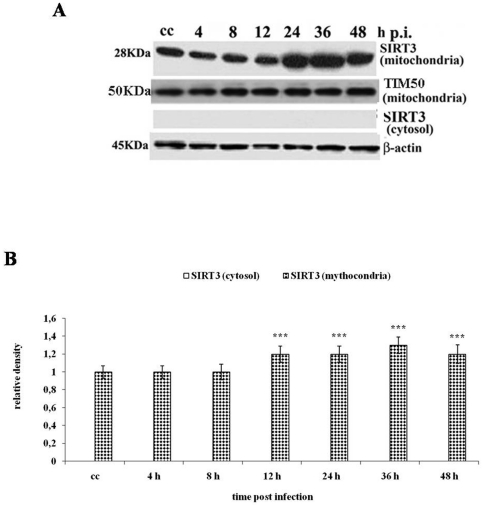
CCoV-II infection modulates SIRT3 protein expression in mitochondrial fraction.(A) Cell lysates were collected at the indicated times p.i., and equal amounts of proteins from each sample were subjected to Western blot analysis and probed for SIRT3. TIM50 was used as a loading control. The molecular weight (KDa) of protein size standards is shown on the left hand side. Blot is representative of three separate experiments. (B) Densitometric analysis of blots relative to SIRT3. The bars represent the mean ± SEM of the results from three separate experiments. Significant differences between CCoV-II-infected cells and control cells are indicated by probability P. *P <0.05, **P <0.01, and ***P <0.001.